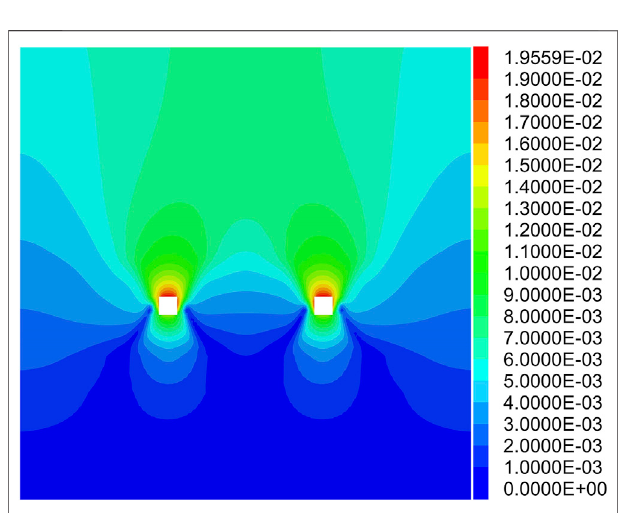
FIGURE 14 | Displacement nephogram (m).